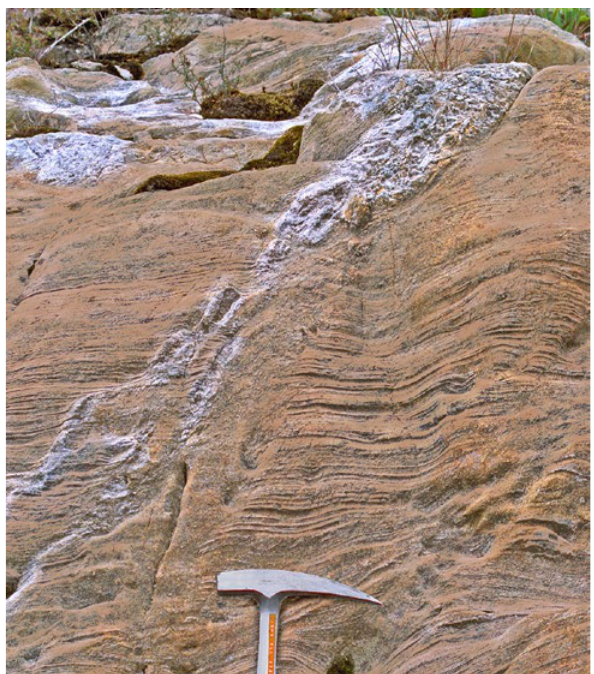
Figure 31. A flow banded mass flow unit, one of the Tasma- nian west coast porphyroids outcrops on Whip Spur above South Queenstown. A clastic dyke or fluid outflow channel intruded shortly after its deposition over other wet sediments. This dyke has a ‘sandy’ matrix similar to that of its porphyroid host but it carri- es rotated pieces of disrupted siliceous flow bands and a ‘jumble’ of these is concentrated in the upper part of the dyke.